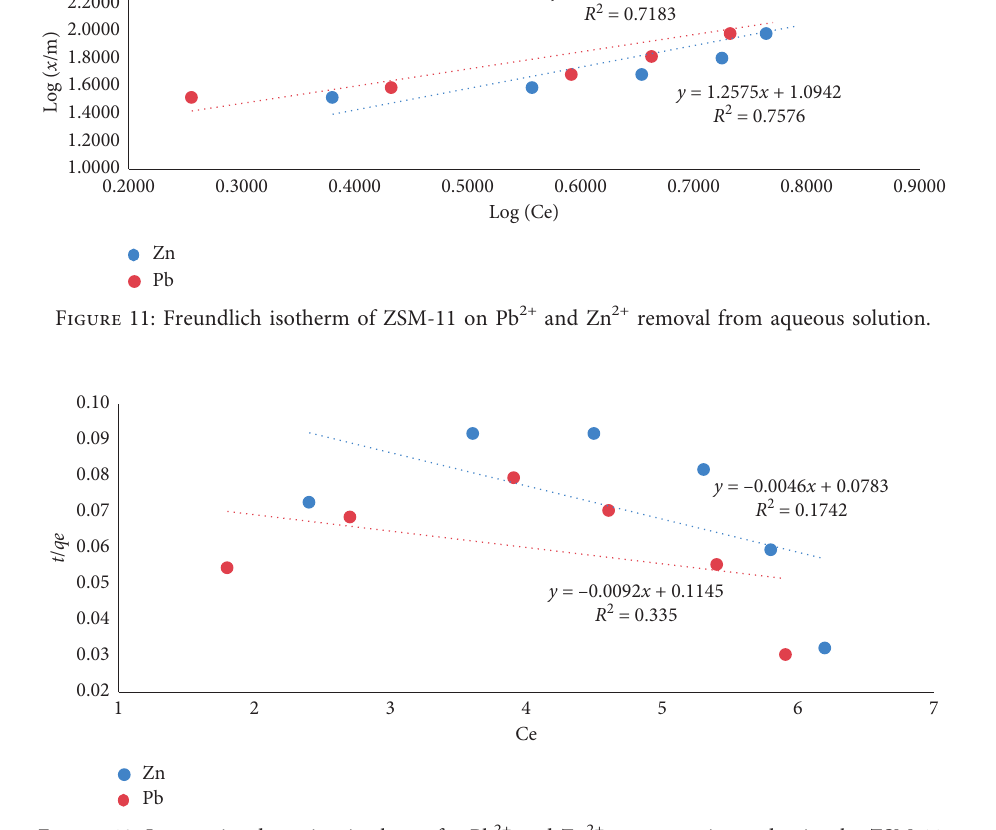
Figure 12: Langmuir adsorption isotherm for Pb 2+ and Zn 2+ concentration reduction by ZSM-11.